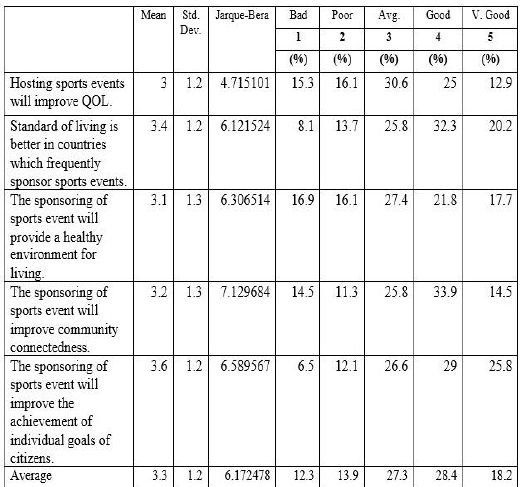
Table 5: Quality of